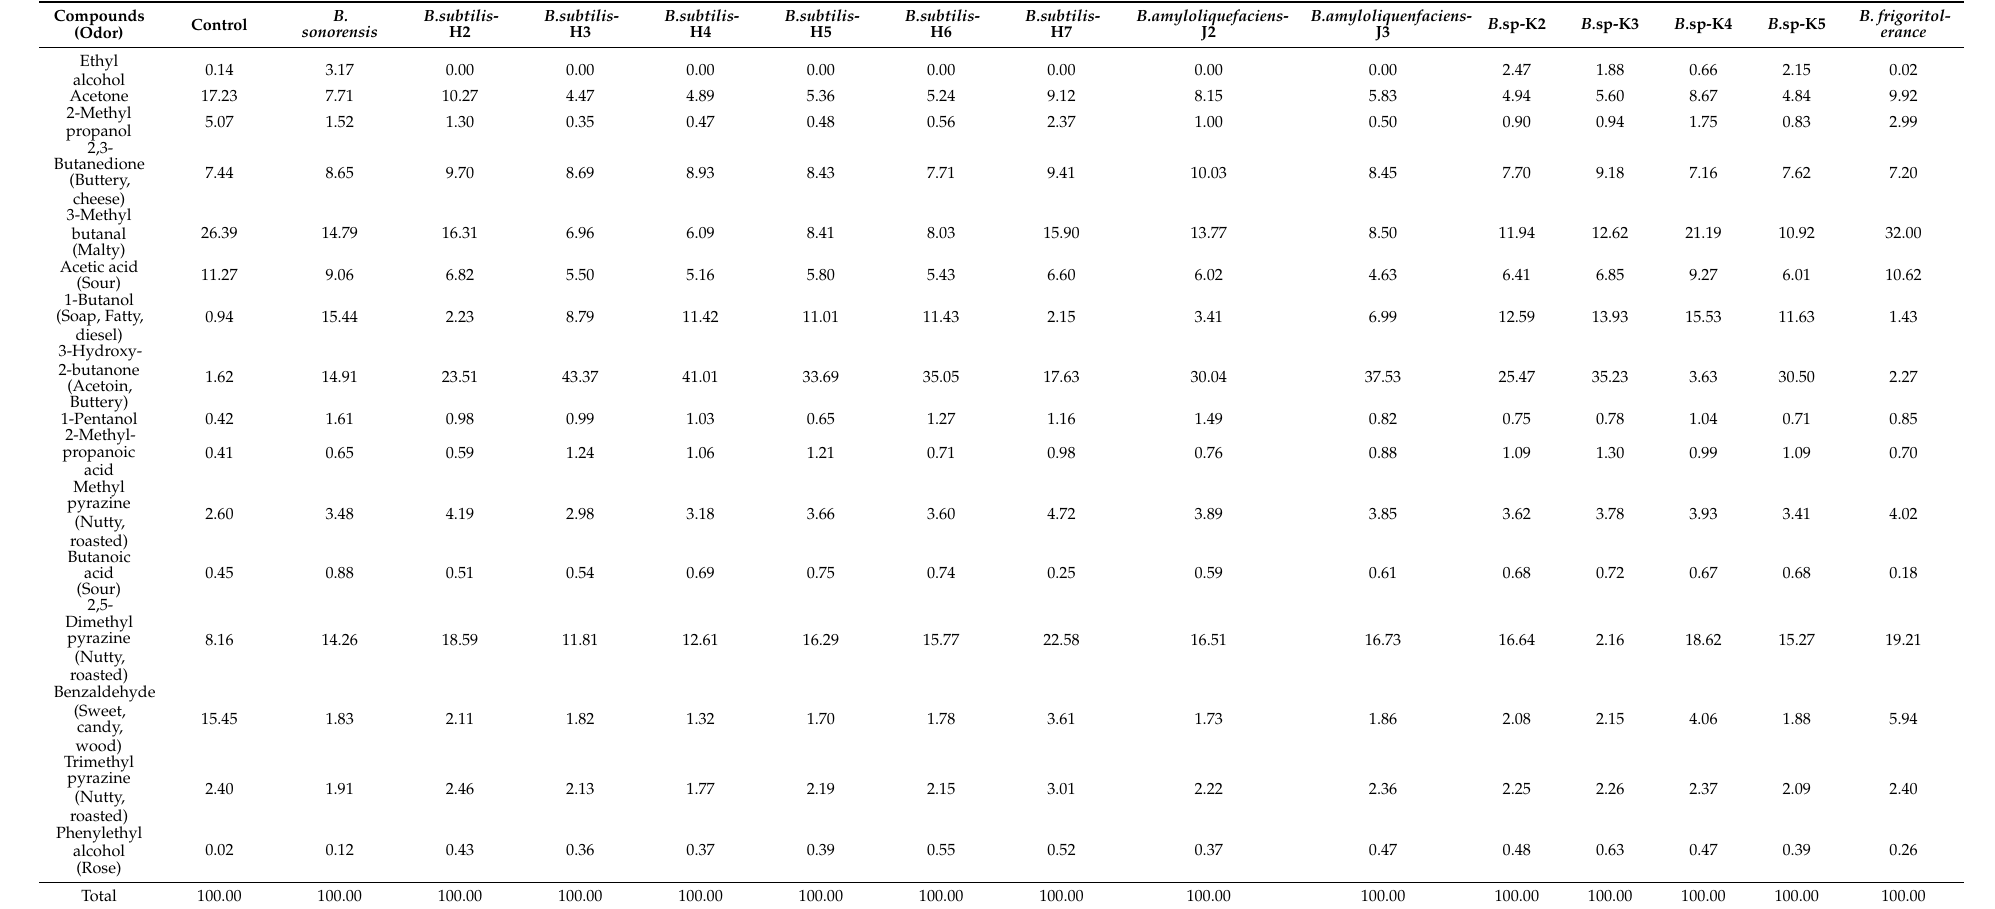
Table 2. Volatile composition of cultures by GC/MS based on area